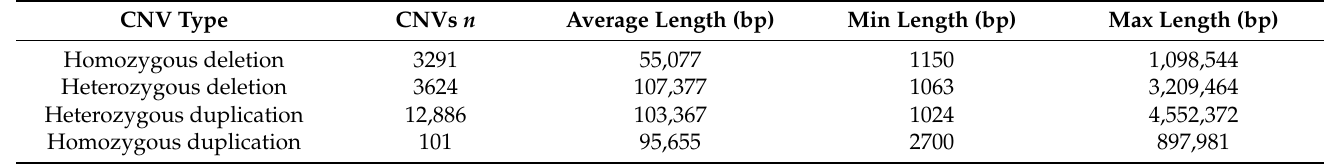
Table 1. Summary of CNVs identified in Pura Raza Española